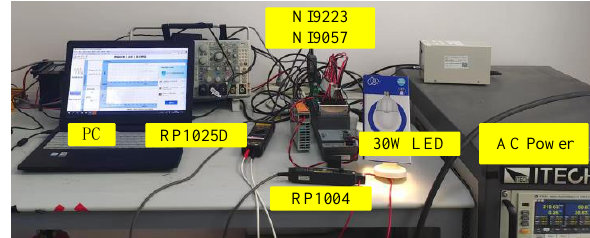
Figure 8. LED test settings.